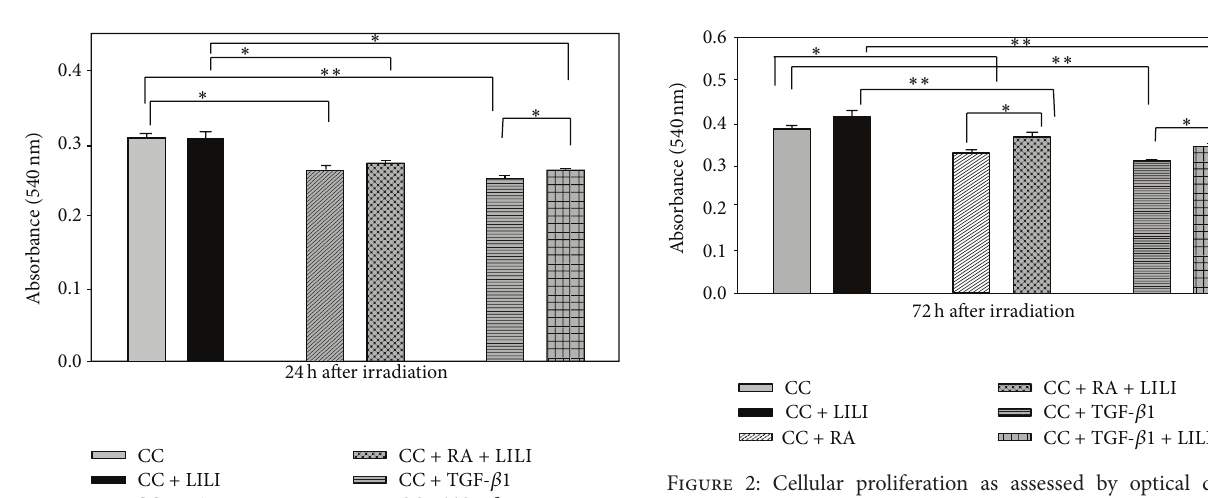
Figure 2: Cellular proliferation as assessed by optical density at 72 h after irradiation. Groups that were irradiated increased in proliferation as compared to those that were not exposed to irradiation but there was a decrease in the groups with growth factors as compared to those without growth